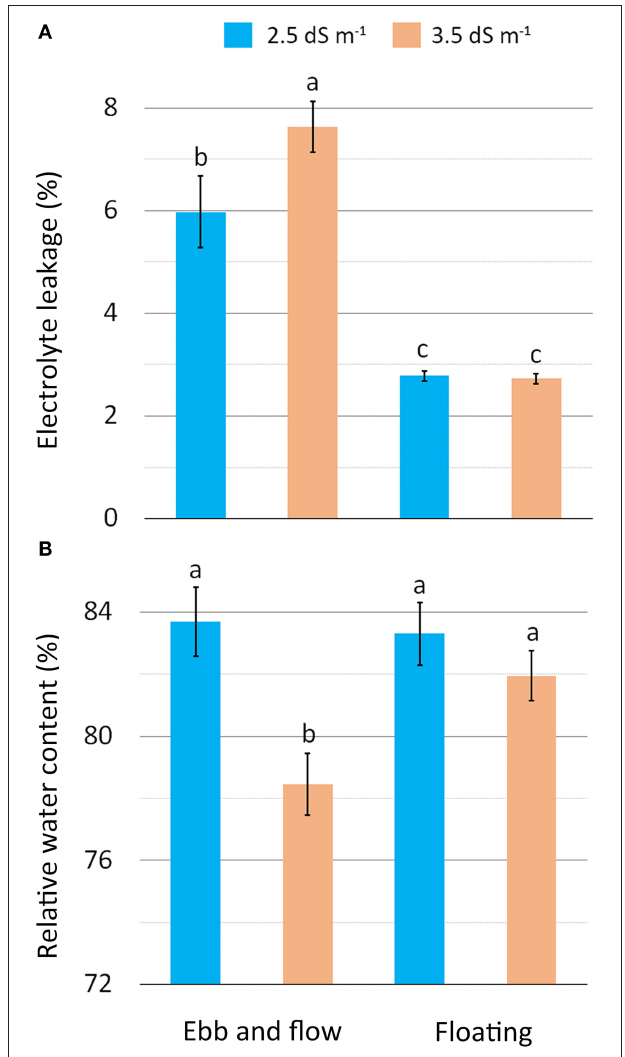
FIGURE 3 | Effect of soilless cultivation system and nutrient solution electrical conductivity on electrolyte leakage (A) and relative water content (B) of romaine lettuce grown in a greenhouse during the autumn. Vertical bars indicate ± SE of mean ( n = 9) of the observed values, with different letters significantly different according to the LSD test ( α = 0.05).